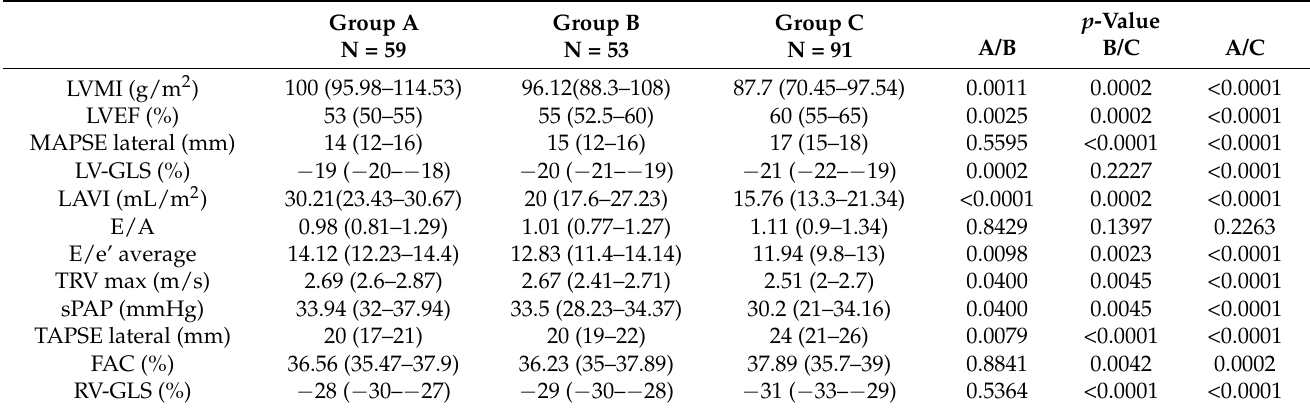
Figure 1. Distribution of factors defining MS. Table 2. Results of the initial TTE assessment.